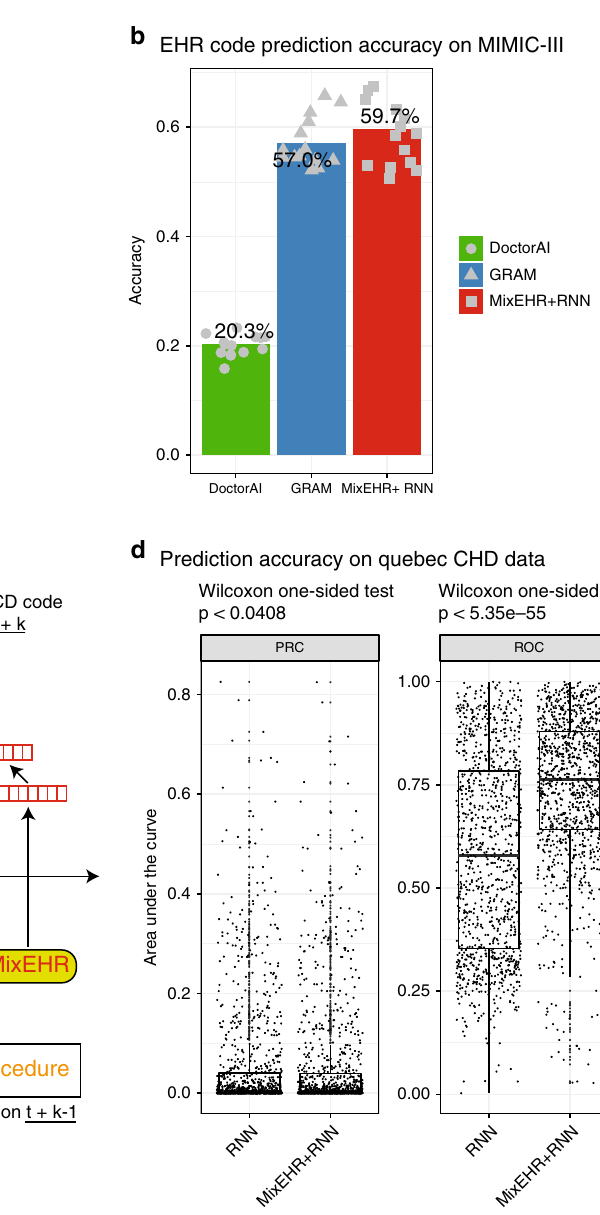
signi fi cantly higher accuracy compared to CF-RBM (Fig. 7b, c; Wilcoxon test p -value < 0.00013, Kolmogorov – Smirnov (KS) test p -value < 1.15 × 10 − 5 ). This is attributable to two facts: (1) Mix- both the lab missing indicators and lab results; (2) MixEHR is